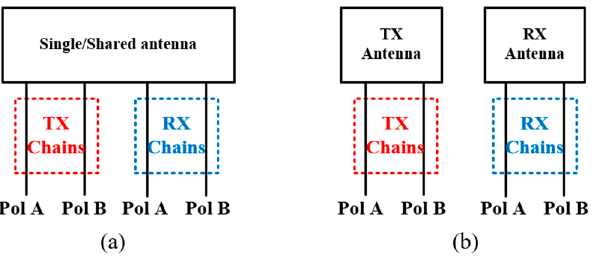
Figure 16. Two kinds of IBFD antenna with two polarizations in TX and RX chains. ( a ) Single/Shared antenna. ( b ) Multiple antennas.